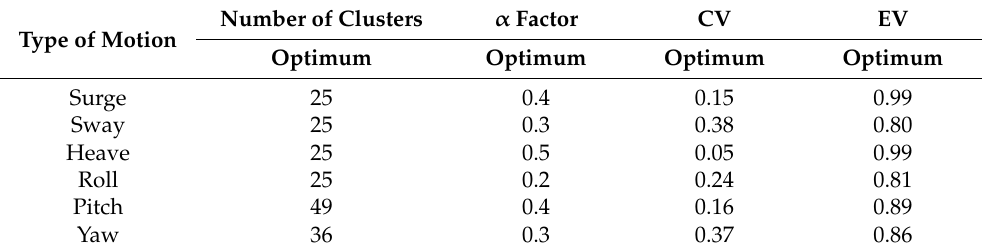
Table 6. Obtained results from the sensitivity analysis for “number of clusters” and “ α ” in the extended version with IW predictor variables. Corresponding CV and EV